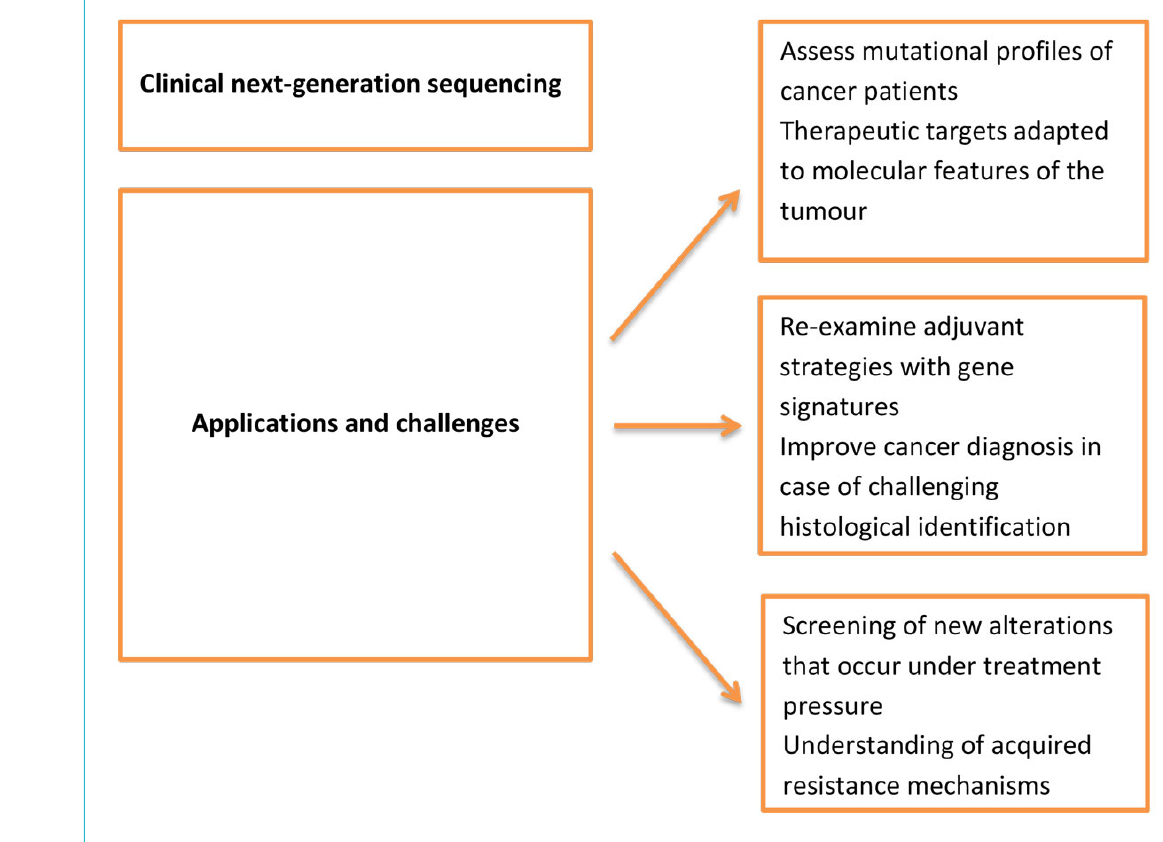
Figure 2: Prospective applications and challenges of next-generation